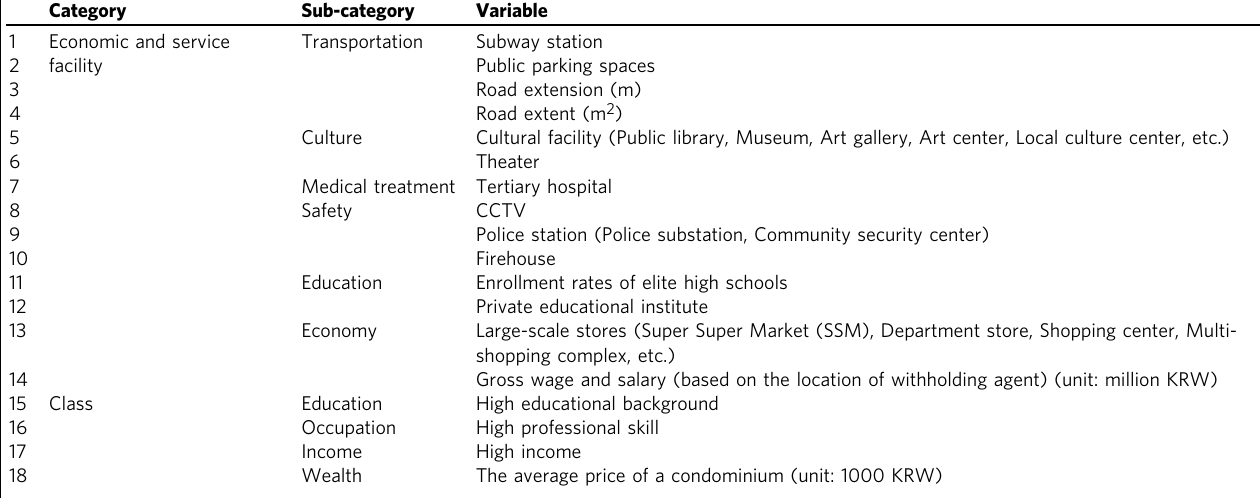
Table 1 List of